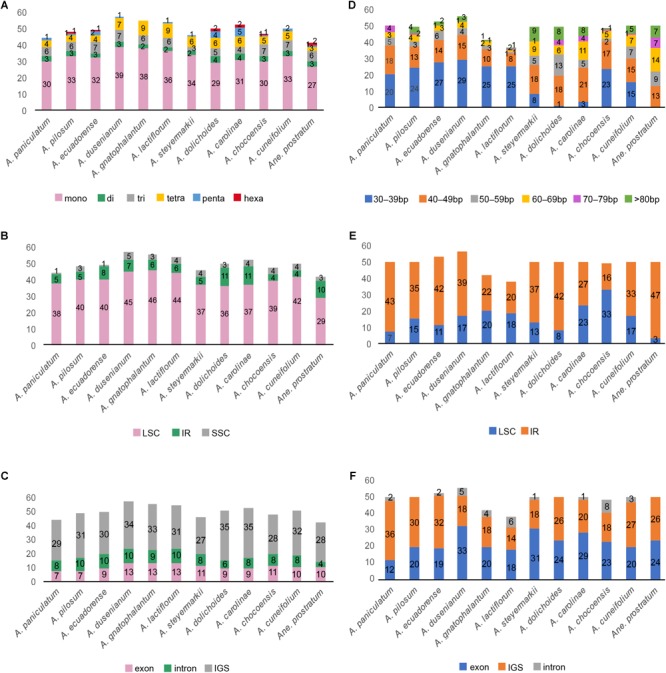
(A–C) Distribution of SSRs in the Amphilophium and Anemopaegma prostratum plastomes. (A) Distribution of SSR types. (B) Number of SSRs per genomic regions. (C) Distribution of SSRs in exon, intergenic spacer (IGS), and intron regions. (D–F) Analysis of tandem repeats in the Amphilophium and Anemopaegma prostratum plastomes. (D) Distribution and length of tandem repeats. (E) Distribution of tandem repeats in genomic regions. (F) Distribution of tandem repeats in exon, intergenic spacer (IGS), and intron regions.